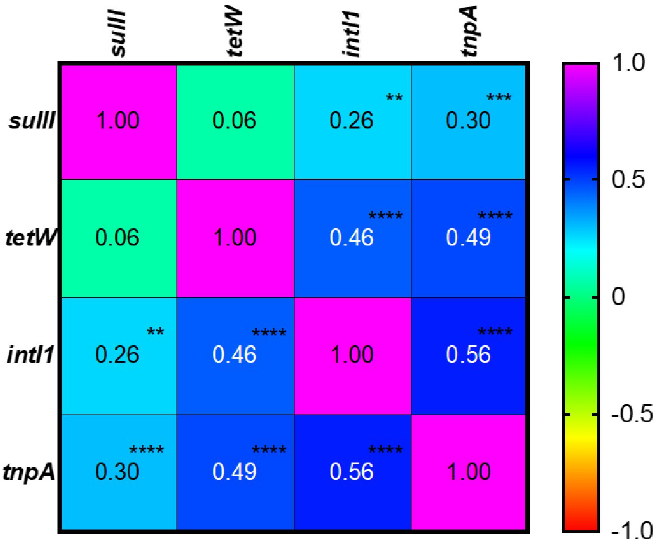
Fig 4. Pearson correlation matrix of relative abundance of ARGs/ MGEs. �� significant at P � 0.01; ��� significant at P � 0.001; ���� significant at P �